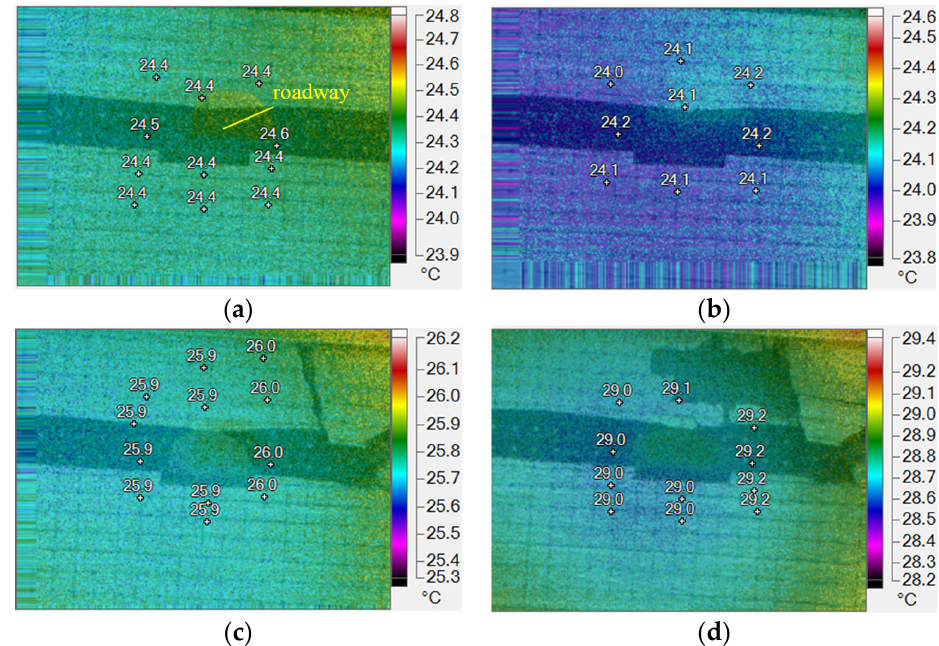
Figure 10. Plane temperature field of surrounding rock in mining roadway in different coal seams.